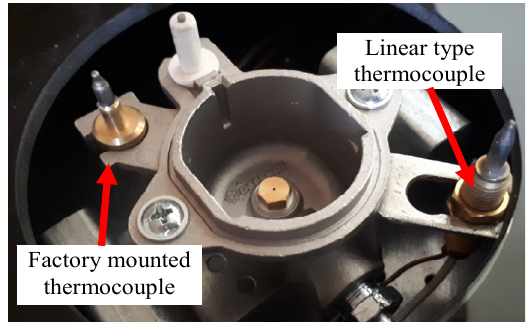
Figure 11. The photo of the used thermocouples .